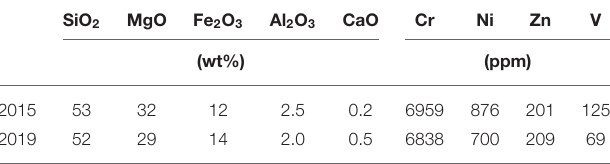
TABLE 1 | Chemical composition of ferronickel slags, measured 4 years